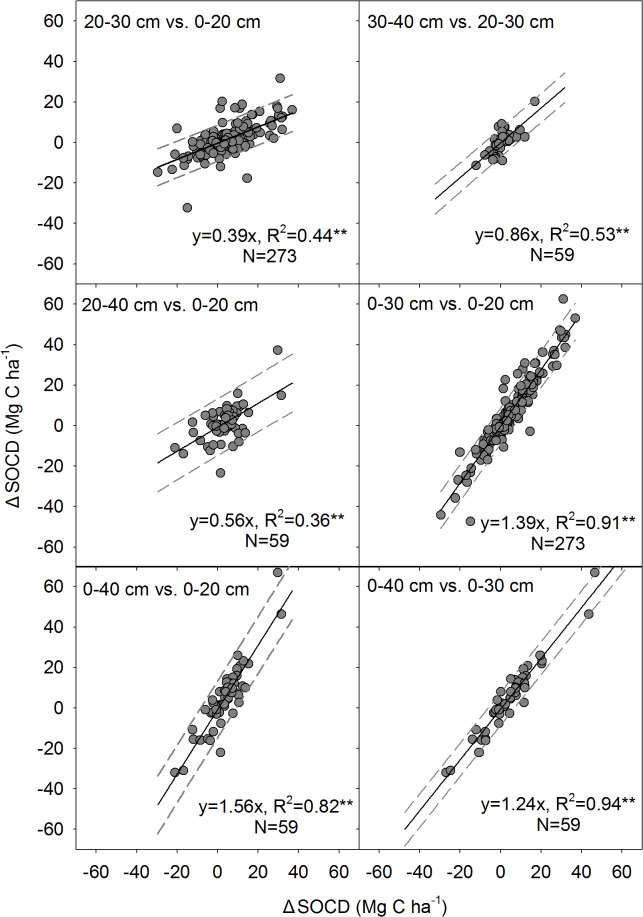
The linear relationship between ΔSOCDs in different soil layers.The dashed lines represent the 95% confidence intervals. The y-axis represents the deeper layers, and the x-axis represents the upper soil layers.